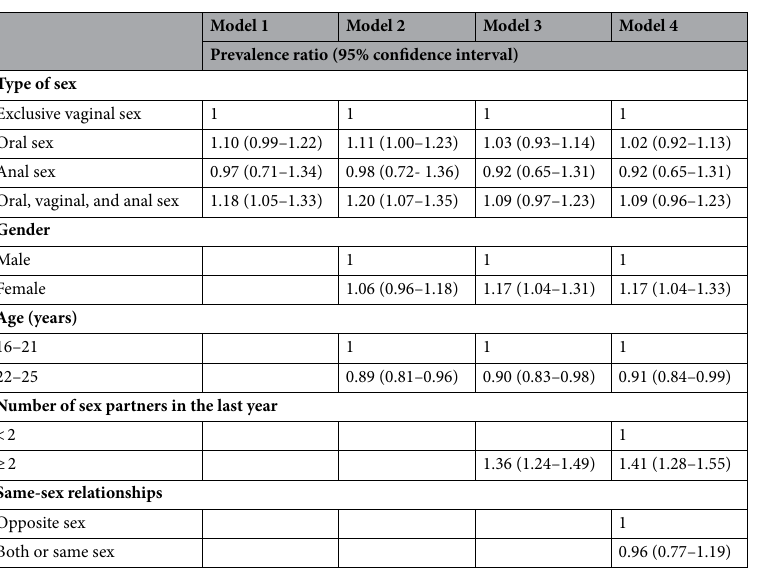
Table 4. Multivariate analyses of factors associated with overall HPV infection. Poisson regression with robust